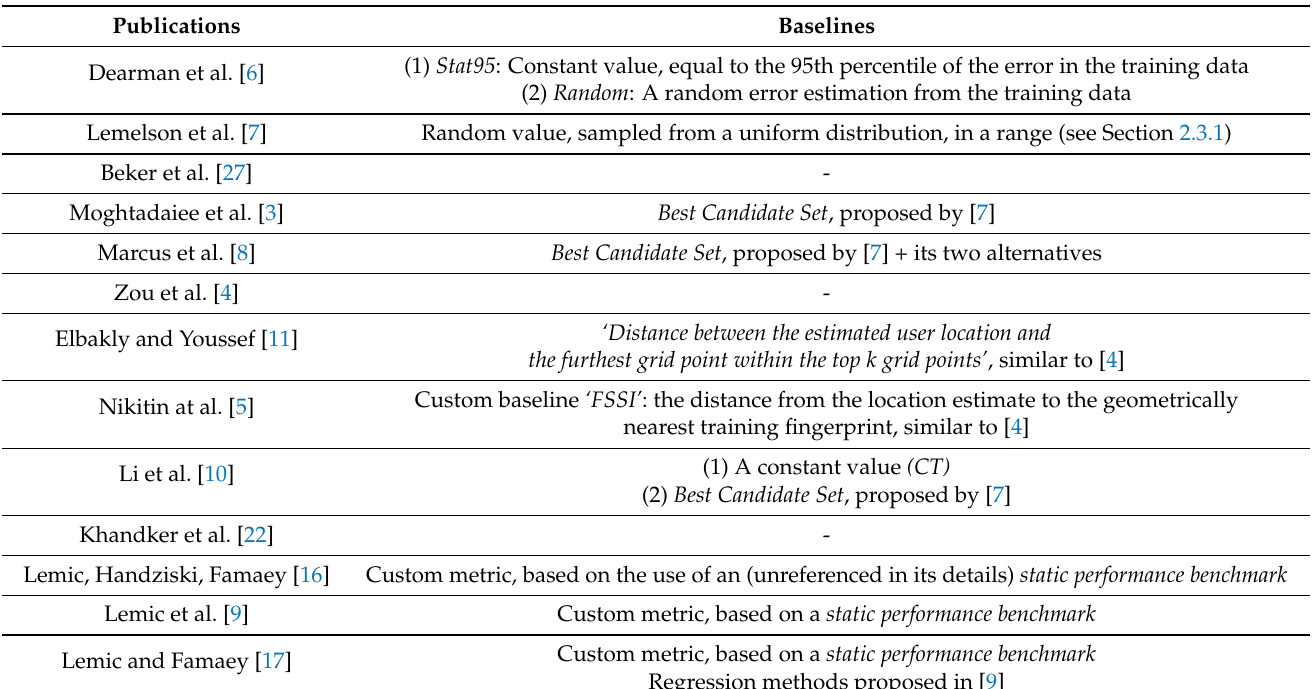
Table 1. Baselines used by related works, for comparatively evaluating their accuracy